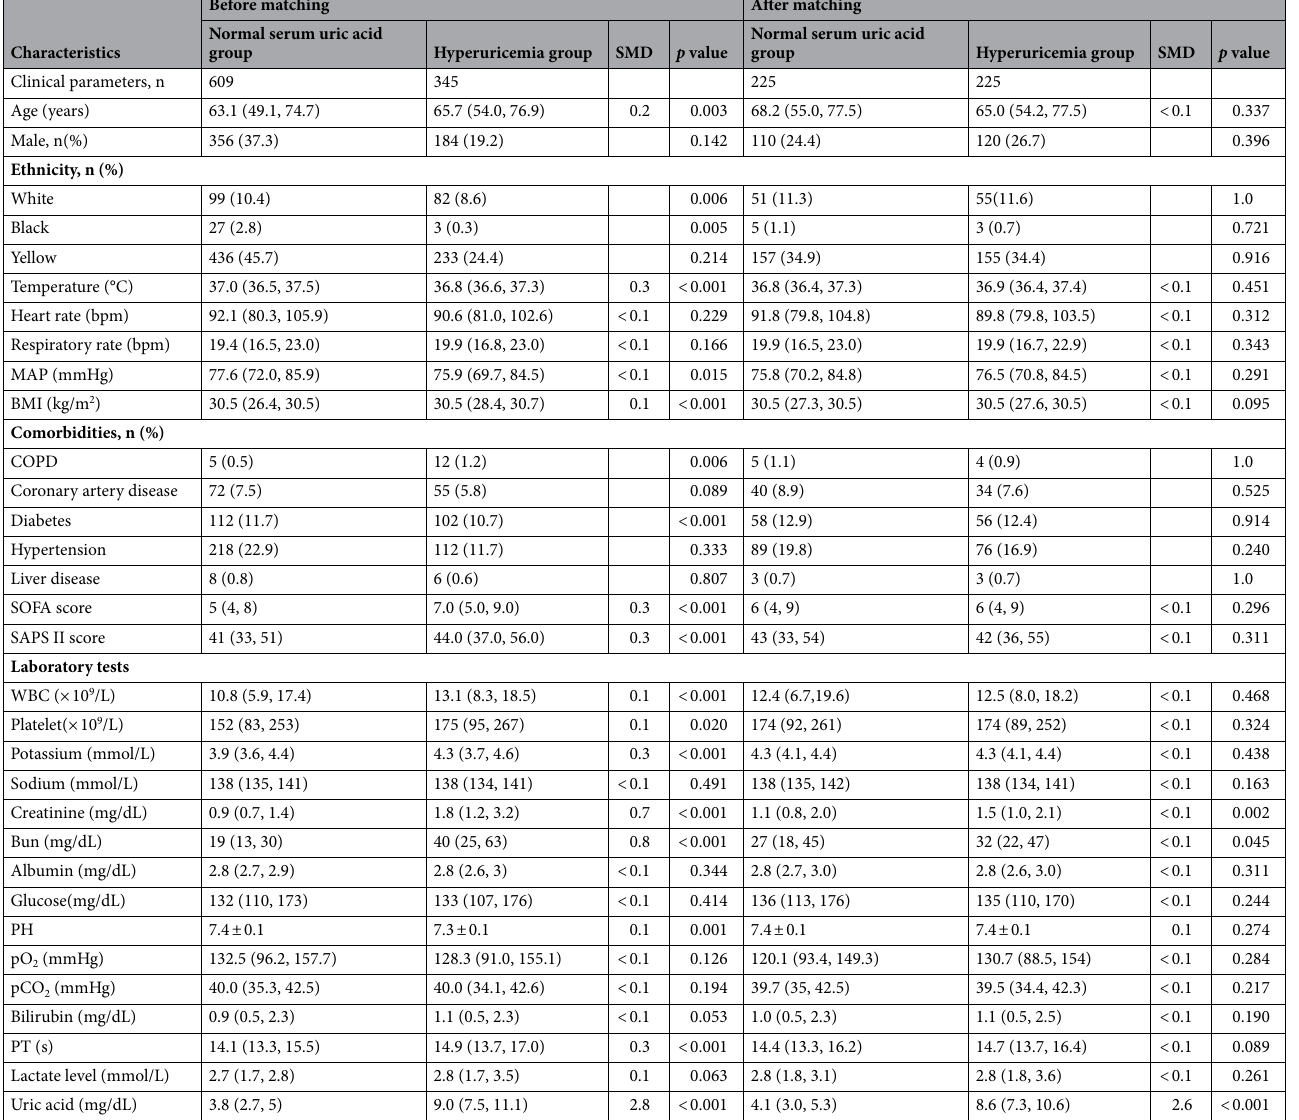
Table 1. Baseline characteristics before and after propensity-score matching. MAP mean arterial pressure, BMI body mass index, COPD Chronic obstructive pulmonary disease, WBC white blood cell, Bun blood urea nitrogen, pO2 partial pressure of oxygen, pCO2 partial pressure of carbon dioxide, PT prothrombin time. Note: Chi-square test and Wilcoxon rank-sum test were used to compare the differences of categorical and continuous variables